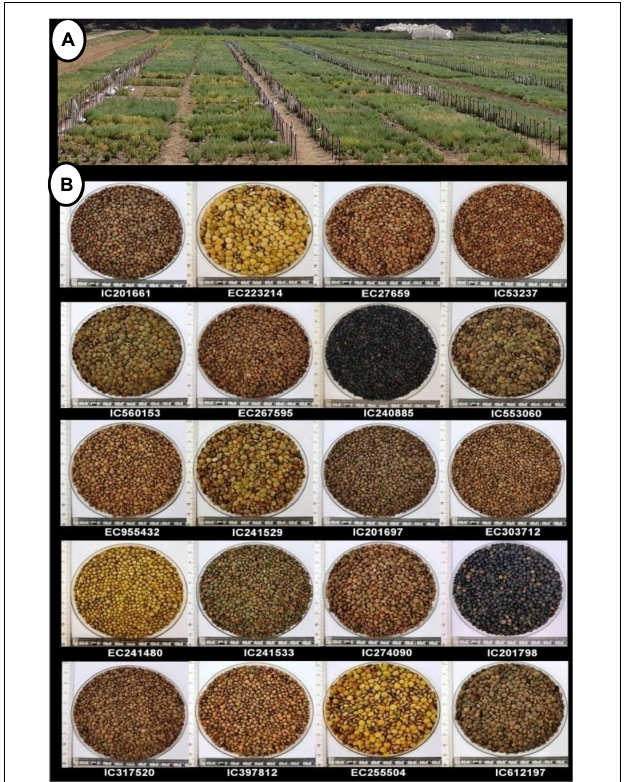
FIGURE 3 | (A) Field view of agro-morphological characterization of lentil germplasm and (B) seed coat diversity.